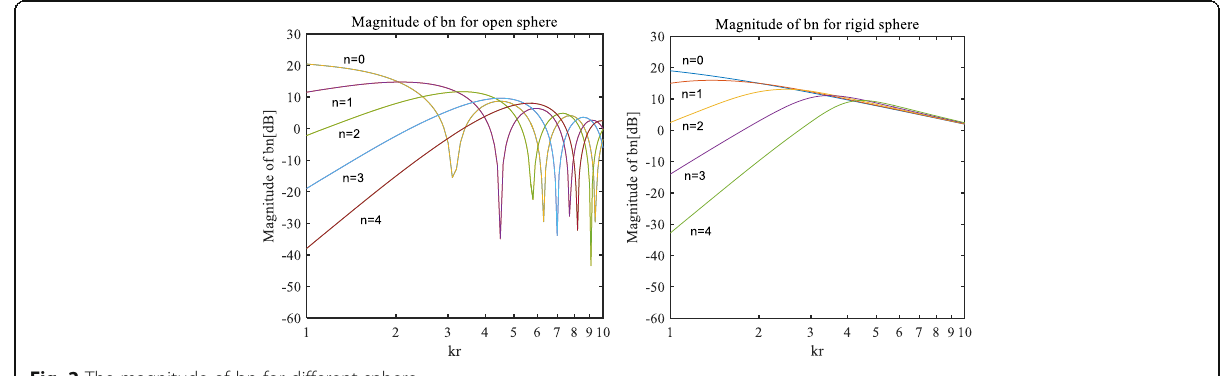
Fig. 2 The magnitude of bn for different